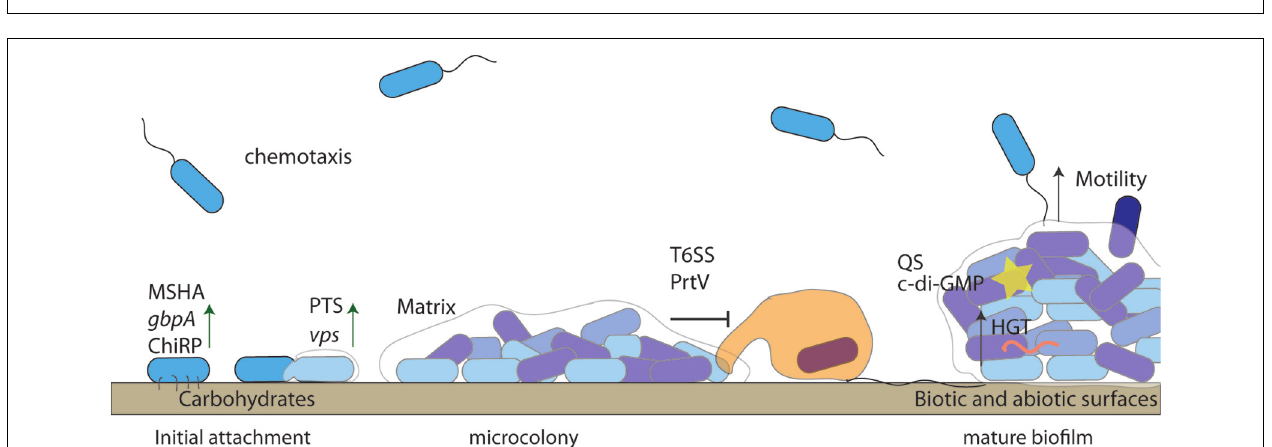
FIGURE 1 | Global distribution of Vibrio cholerae . Triangles indicate where V. cholerae was detected by molecular and/or culture-based methods. Red indicates O1/O139 detection, light blue non-O1/non-O139 detection, and dark blue did not specify. Referenced studies here are only a small fraction of the studies published for certain areas and should guide as an example. North – and Middle America: (Colwell etal., 1981; Ogg etal., 1989; Blackwell and Oliver, 2008; Lizárraga-Partida etal., 2009; Hill etal., 2011; Dickinson etal., 2013), South America: (Franco etal., 1997;